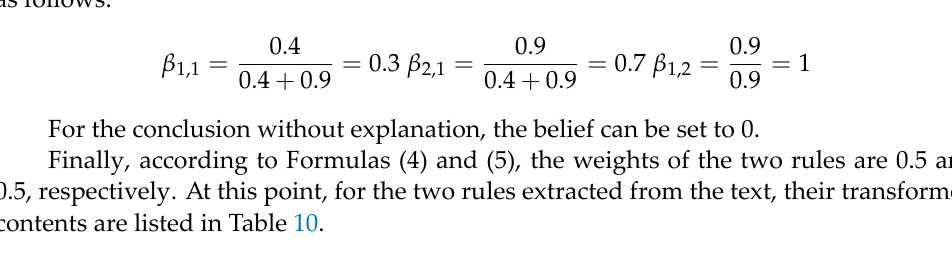
Table 10. Values of rule parameters after